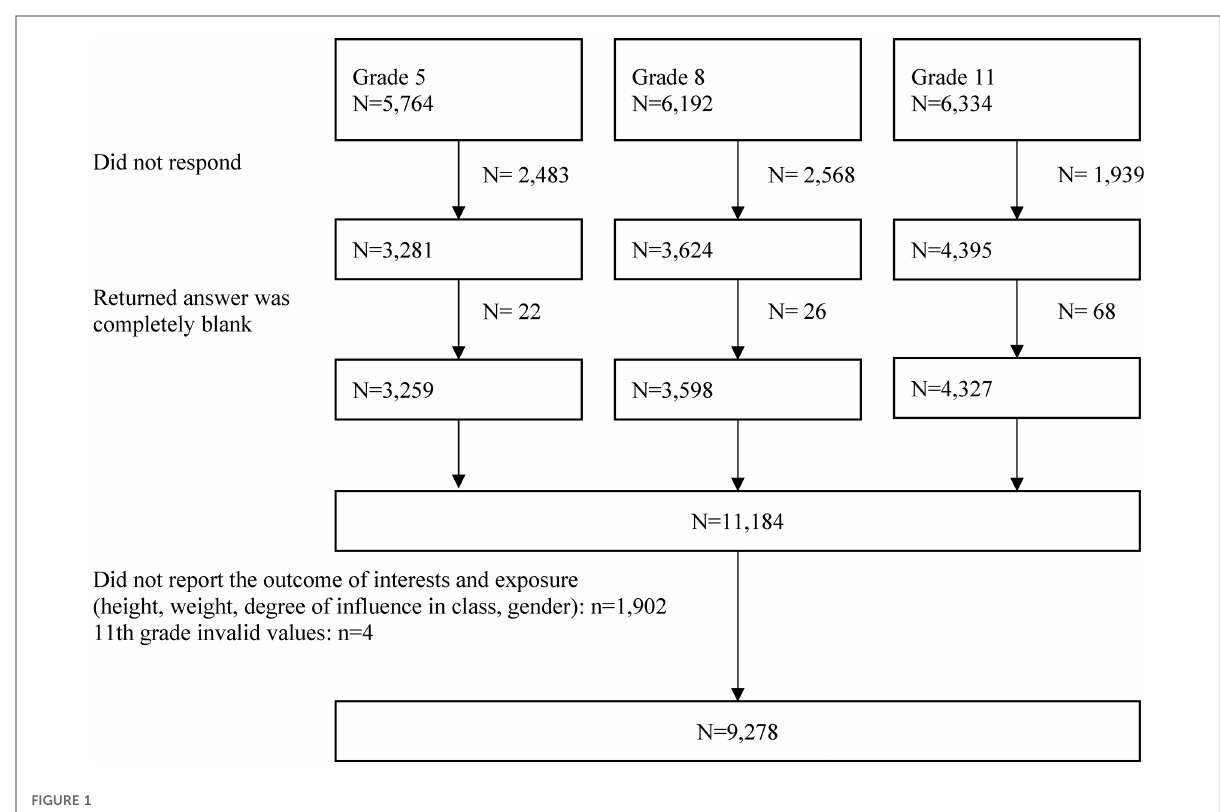
FIGURE 1 Requirement fl